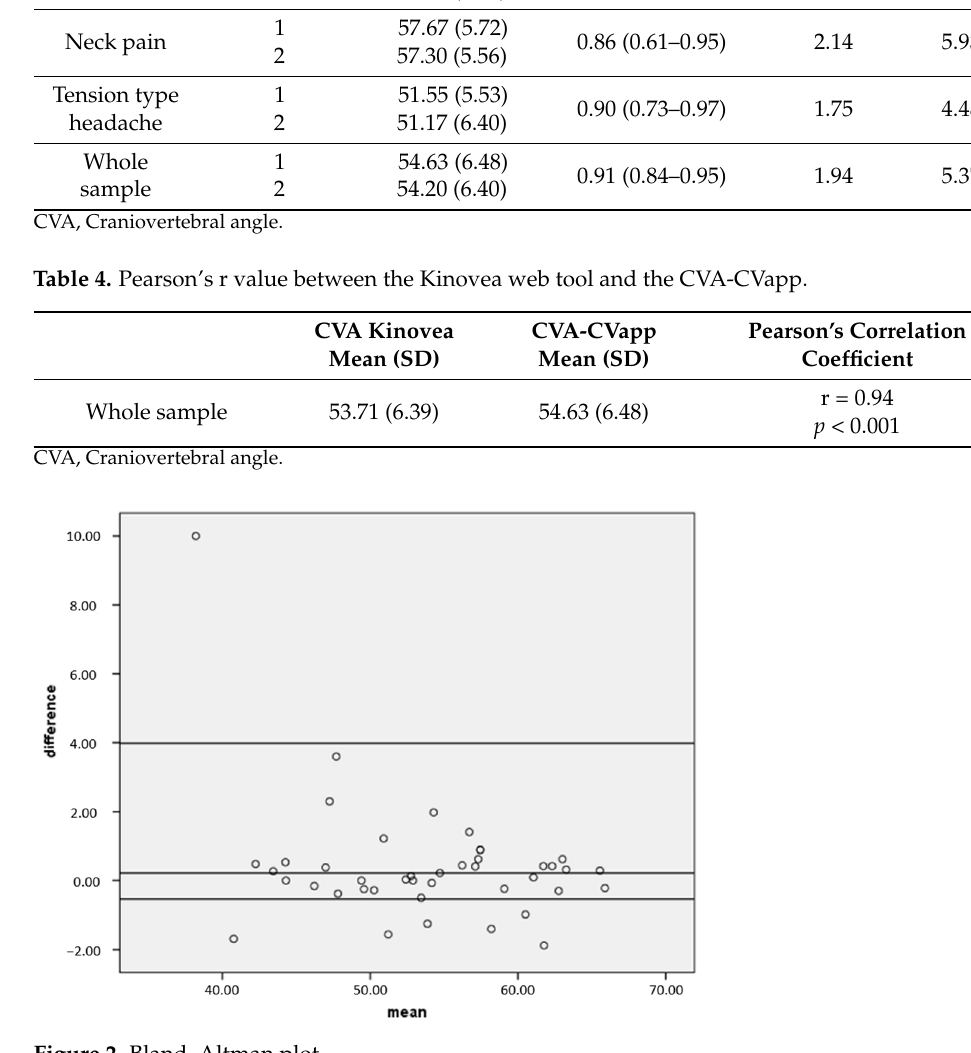
Table 3. Inter-rater reliability for subgroups and the whole sample.